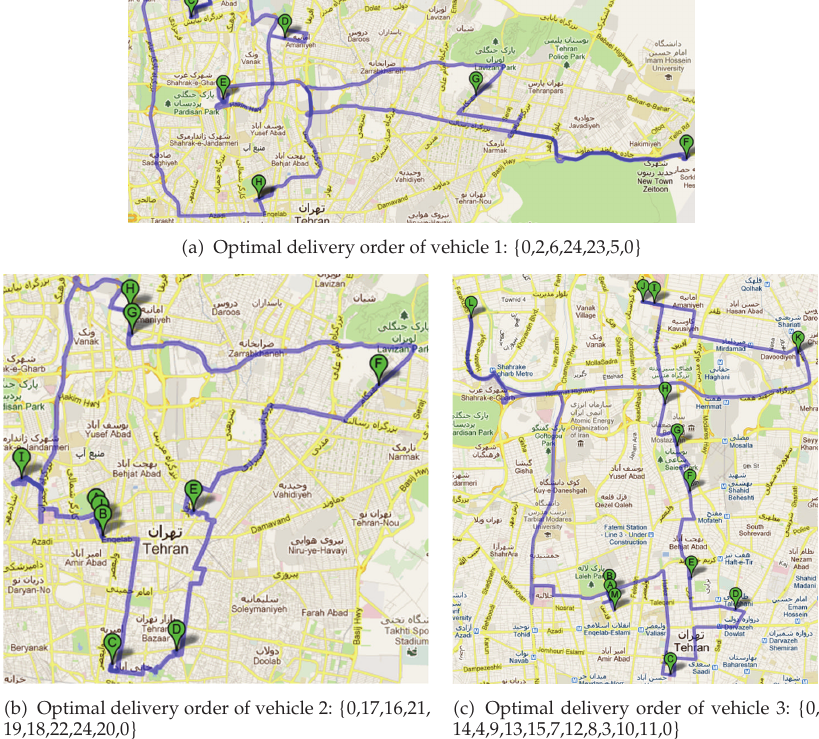
Figure 5: The optimal delivery orders when hiring three vehicles, (cid:6) a (cid:7) vehicle 1, (cid:6) b (cid:7) vehicle 2, and (cid:6) c (cid:7) vehicle 3. Table 9: The experimental result of solving the blood product distribution problem for 24 hospitals. Vehicle no. 1 Vehicle no. Number of vehicle (cid:6) route (cid:7)